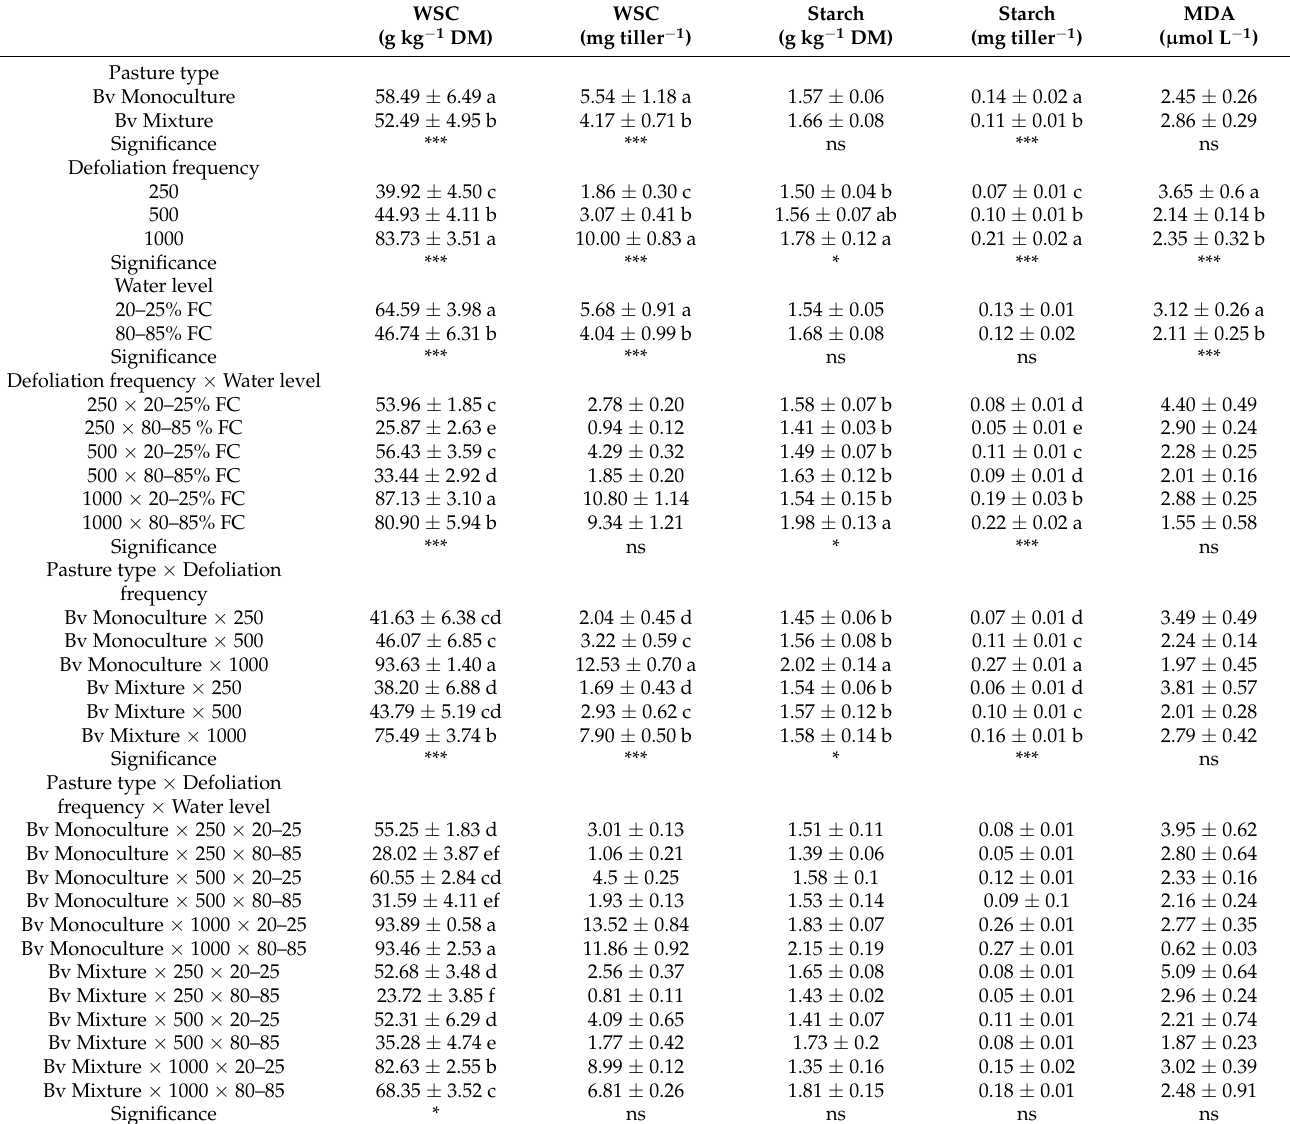
Table 3. Stubble water-soluble carbohydrate (WSC) content (mg plant − 1 ) and concentration (g kg − 1 of dry matter, DM), stubble starch content (mg plant − 1 ) and concentration (g kg − 1 DM) and leaf malondialdehyde (MDA) concentration ( µ mol L − 1 ) of Bromus valdivianus plants grown under two pasture types (monoculture and in a 50/50% mixture with Lolium perenne ), and subjected to three levels of defoliation frequency (250, 500 and 1000 accumulated growing degree days), and two levels of soil water content (80–85% and 20–25% of field capacity (FC)). Values are presented as mean ±